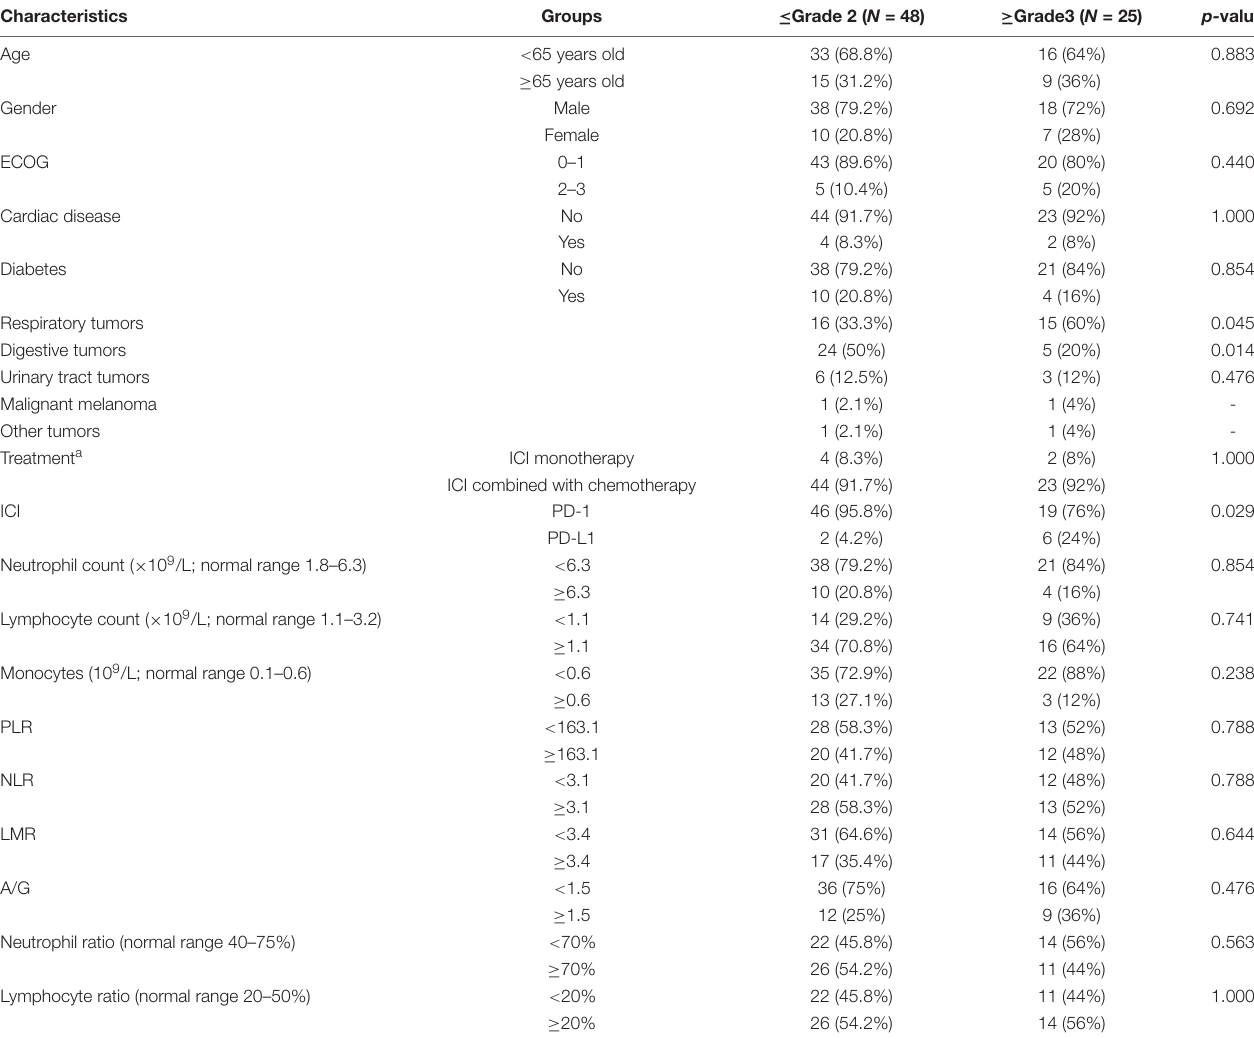
TABLE 3 | Characteristics of patients with cardiotoxicity.